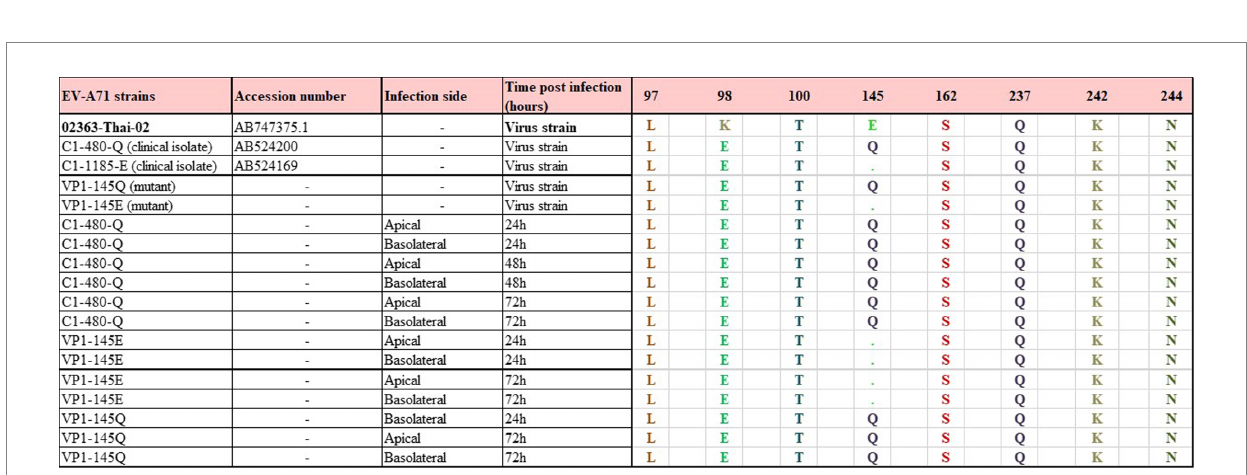
FIGURE 3 Representation among VP1 amino acid sequences of the EV-A71 mutant and clinical isolate strains and collected media from the infected monolayers. VP1 amino acid sequences were aligned to Enterovirus A71 genomic RNA complete genome strain: 02363-Thai-02 (accession number AB747375.1). Only qPCR positive samples were included. No changes and no adaptations were observed before and over the course of infection.*Sample ID used in the Supplementary Figure S3.